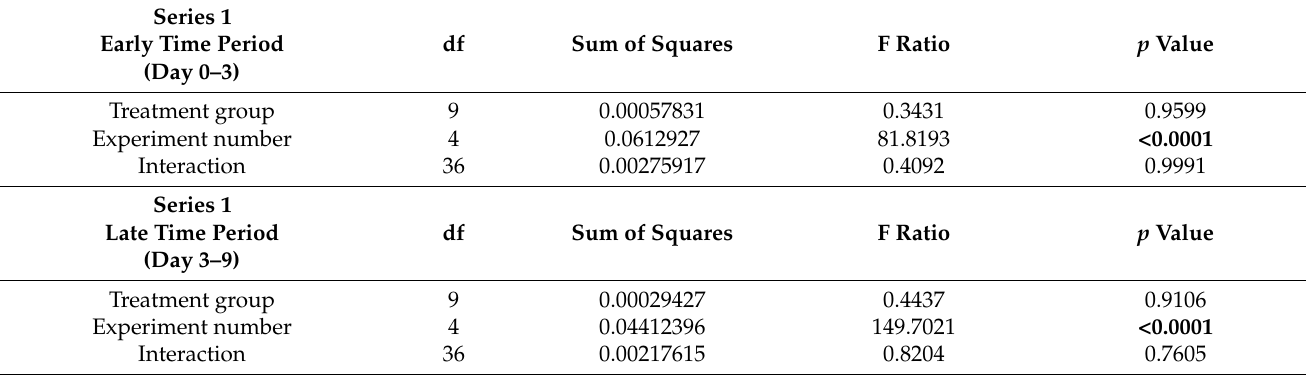
Table 4. Statistical analysis of experimental series 1. Results of a two-way ANOVA of series 1 for single treatment (As 2 O 3 17x–18x, 21x–23x, 28x, 30x, and 33x) and control (unsuccussed and succussed water) groups for n = 5 experiments in early (day 0–3) and late time period (day 3–9). df—degree of freedom. Significant values are printed bold.